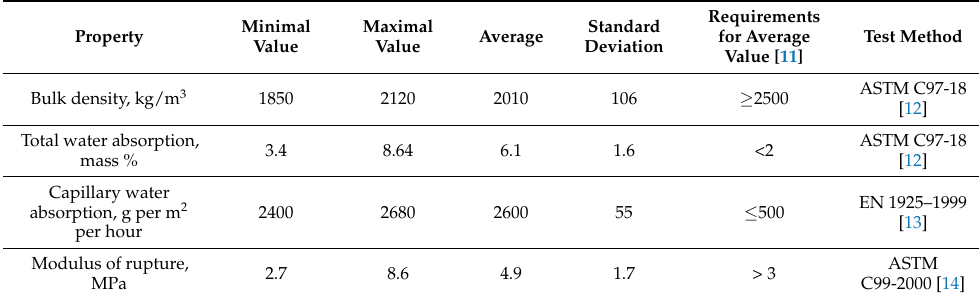
Table 1. Properties of original kurkar sandstones used in the Panorama Sea Walls.